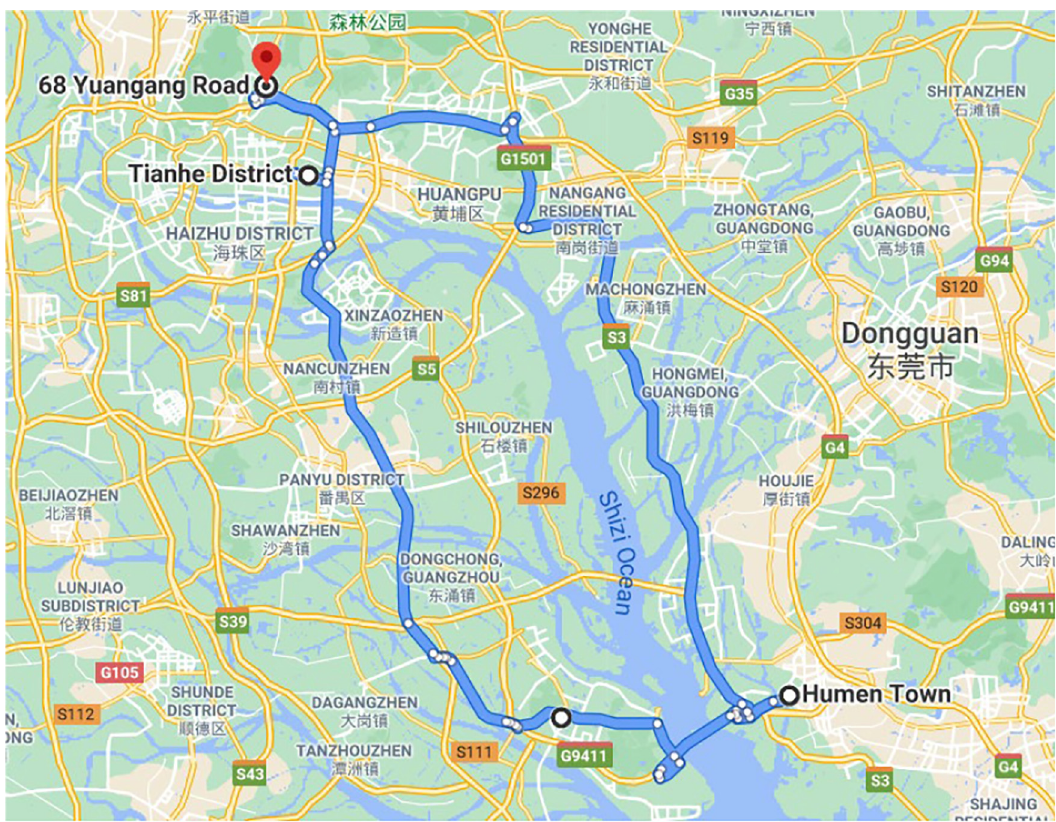
Figure 4 The fi xed route for conducting the SA